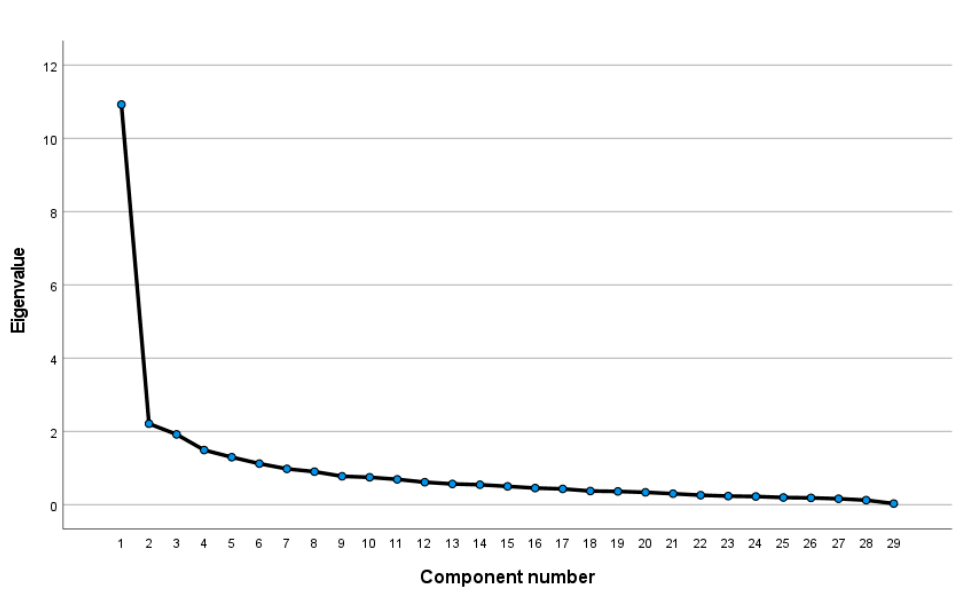
Figure A1. Scree plot of the 29-item MENQOL.